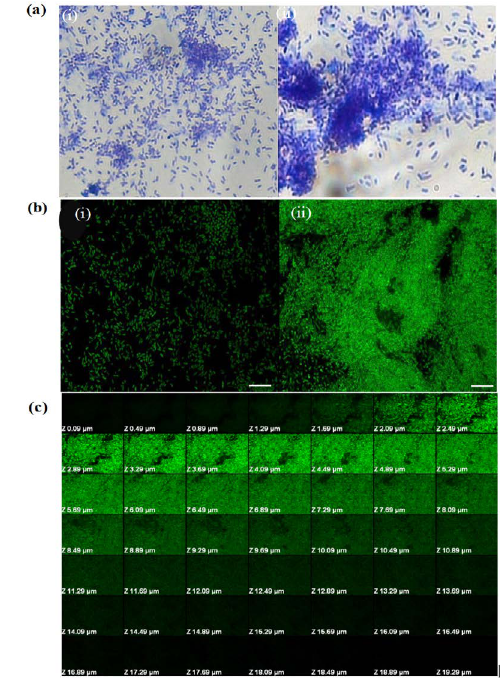
Fig. 2. (a) Biofilm formation on glass coverslips by fluorescent Pseudomonas strains using crystal violet assay. (i) MW3,(ii) MW4.(b) CLSM images of biofilm formed by fluorescent Pseudomonas strains on glass coverslip under stationary conditions. (i)MW3,(ii) MW4.Biofilms were stained with acridine orange. Magnification is 100x. Scale bars = 5 µm. (c) Confocal laser scanning micrographs of Z-stack analysis of Pseudomonas fluorescens (MW4) biofilm formed on glass